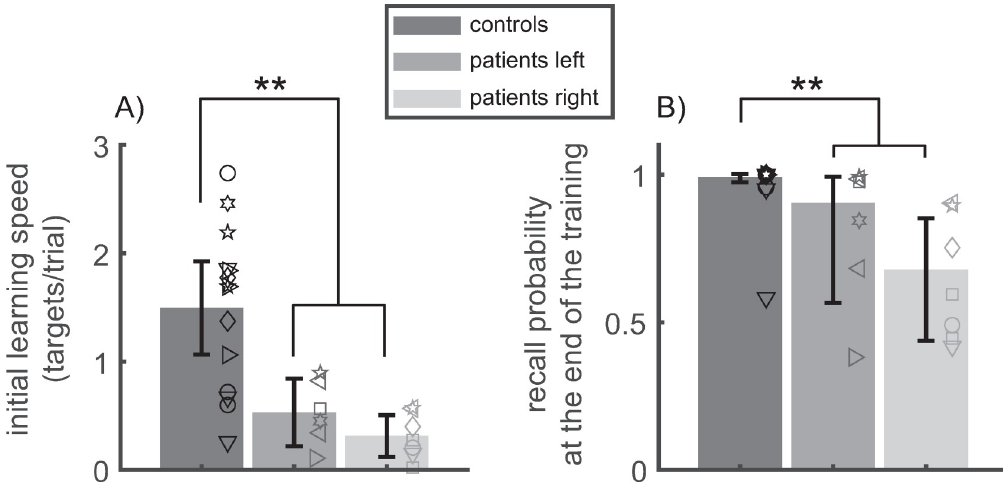
Fig 4. Learning progress during the initial training (Session 1) with DILSS. A) initial learning speed (targets/trial). Each symbol indicates the slope of the cyan line in Fig 3A, multiplied by the total sequence length (20) for one subject. B) final recall probability at the end of Session 1. Symbols show individual values. Bars: median; Whiskers: 95% confidence interval of the median. Both learning speed and final recall probability were clearly impaired (solid double asterisk: p < 0.001) in patients.